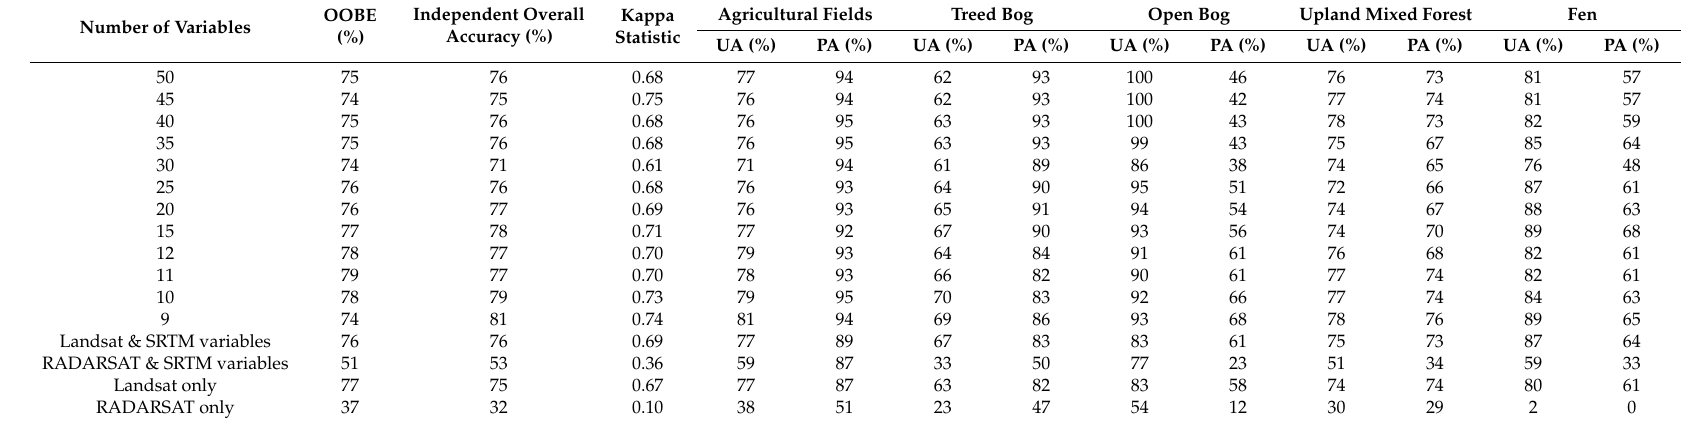
Table A8. Statistical results from the RADARSAT-2 (13 July 2014), Landsat-8 (27 June 2014), and SRTM variables spring model. The first iteration was run with all 50 variables, and variables ranked to be unimportant were then removed until 9 variables remained. The final variables in the model with the highest independent overall accuracy (9 variables) in order of decreasing importance were the six Landsat-8 bands, Alpha angle, HH+VV real component of the correlation coefficient, and SRTM DEM).